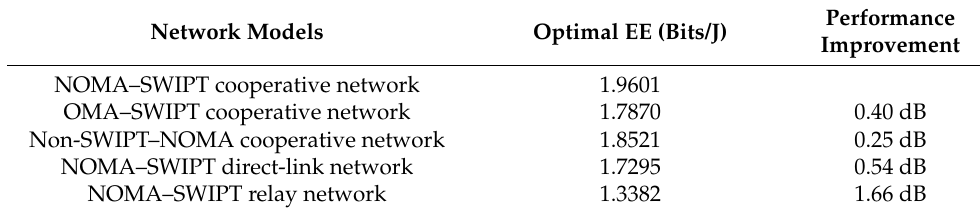
Table 2. Optimal energy efficiency in different network